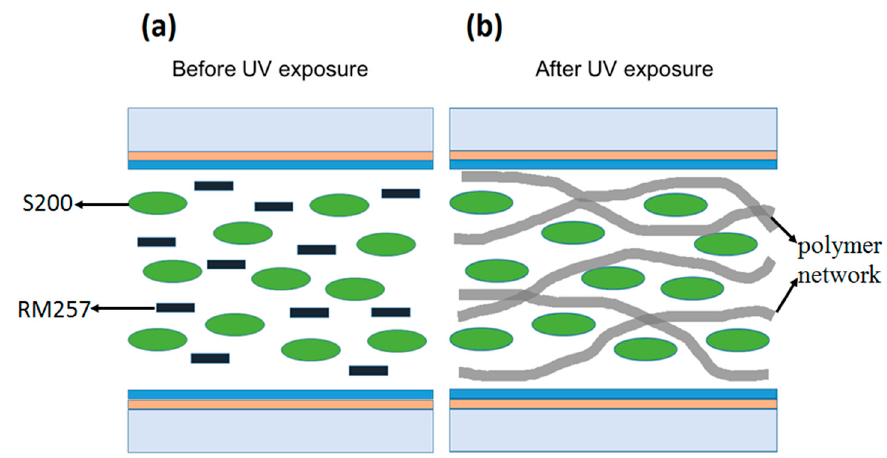
Figure 2. ( a ) Mixture of the liquid crystal (LC) host and photopolymer sable monomer filled into a LC cell. ( b ) The form of the polymer network after the UV exposure.